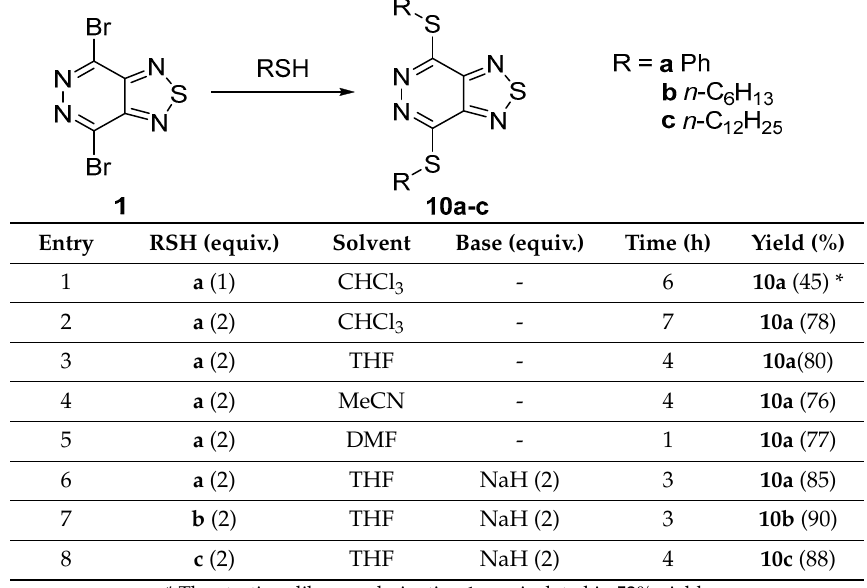
Table 2. Reaction of 4,7-dibromo[1,2,5]thiadiazolo[3,4- d ]pyridazine 1 with S